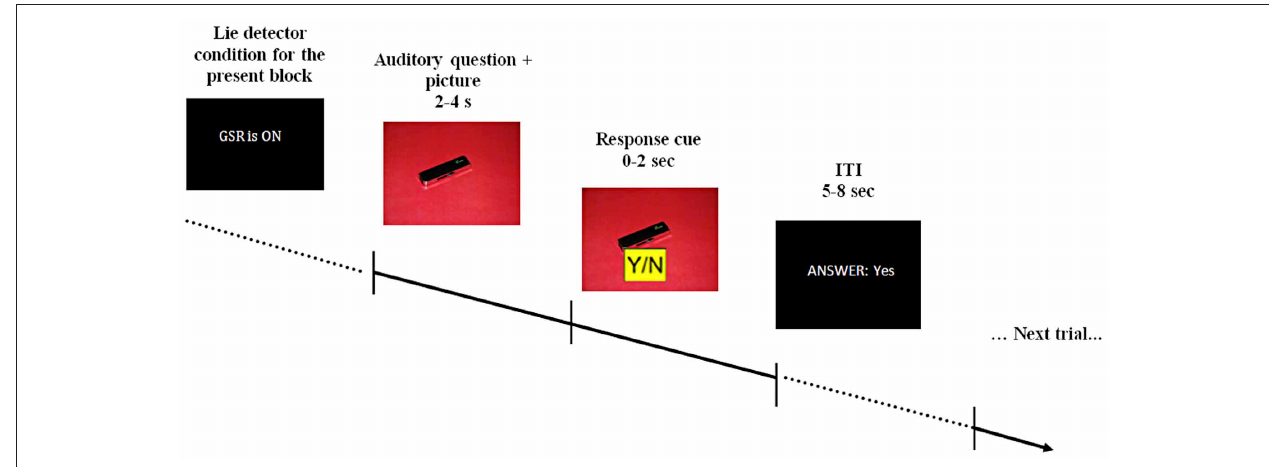
FIGURE 1 | A schematic example of the stimulus display. At the beginning of each block participants were told that the lie-detector (represented by the acronym GSR, for galvanic skin response) was either on or off. During the interrogation, pre-recorded auditory questions were read out over earphones, accompanied by appropriate visual presentations (question presentation took 2–4s). After the question was completed, a response cue appeared on the screen for 2s, during which participants